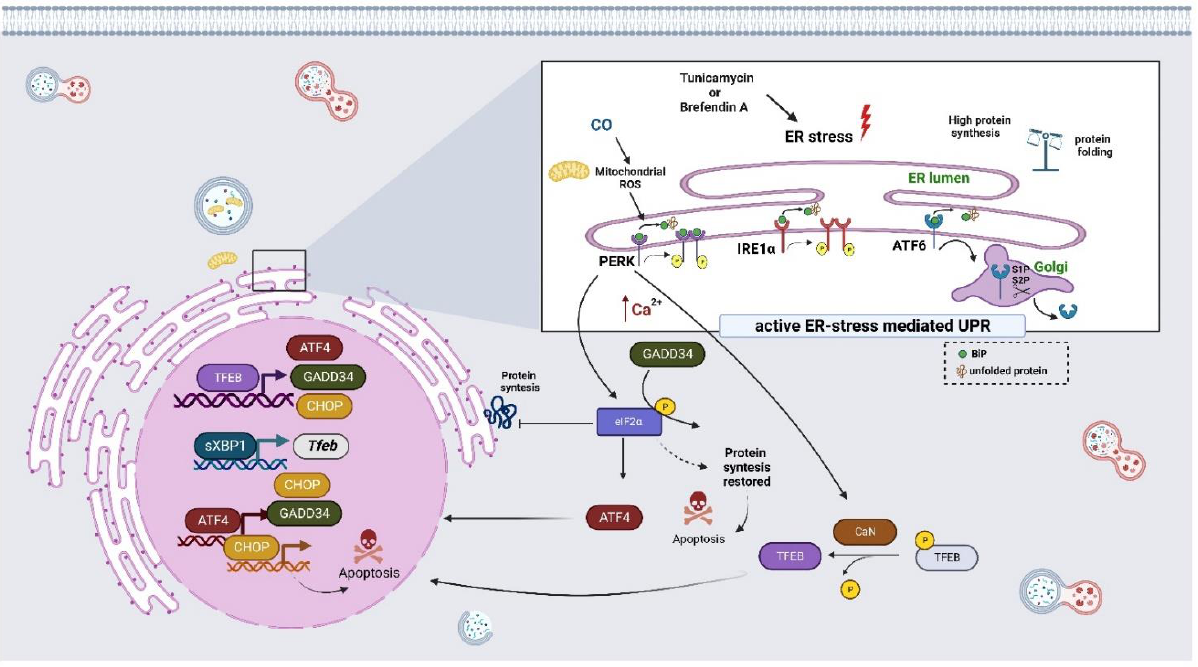
Figure 3. The TFEB regulates the expression of several regulators of the ER stress response. ER stress, triggered by several compounds, promotes the nuclear localization of TFEB in a PERK-, ATF6- , IRE1α -, and calcineurin-dependent manner that consequently induces the transcription of UPR-related genes to restore ER homeostasis and support cell survival or apoptosis, if the stress is persistent.